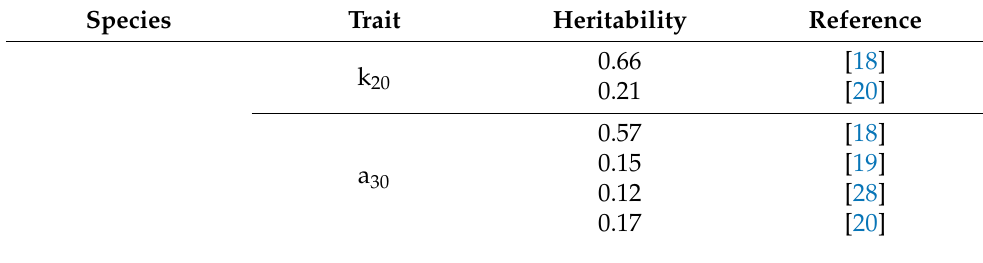
Table 2. Cont. Species